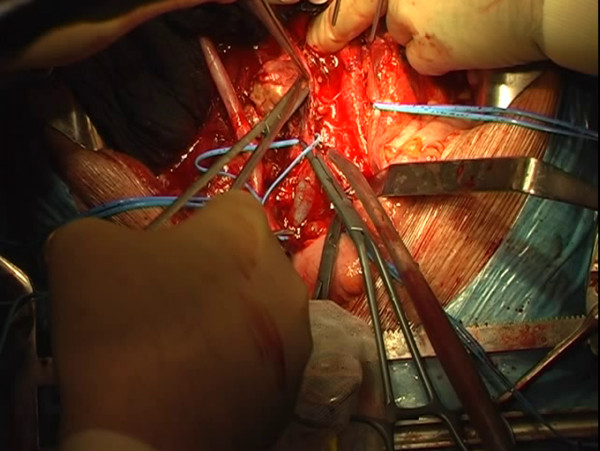
During the dissection, an attempt to free the cava vein from the mass is made, but the caval wall is massively infiltrated by the lesion.